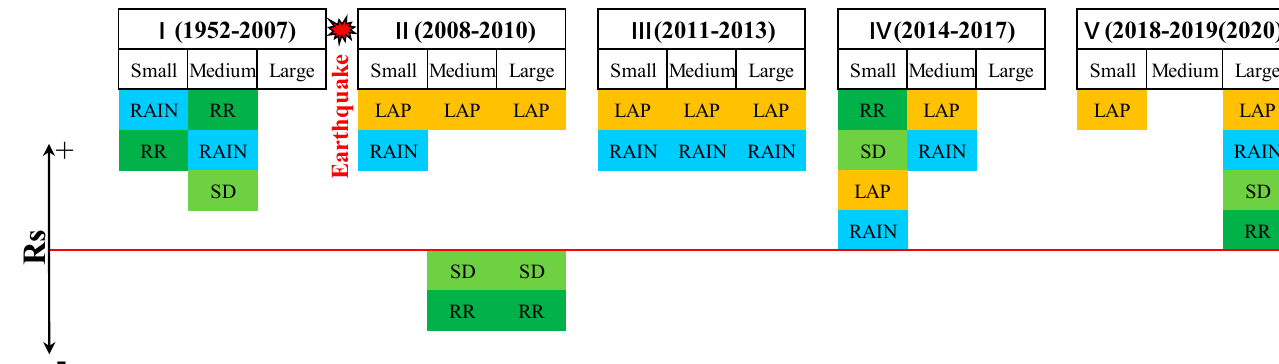
Figure 7. Ranking of correlation coefficients of the main controlling factors for each time period (descending order of each column).